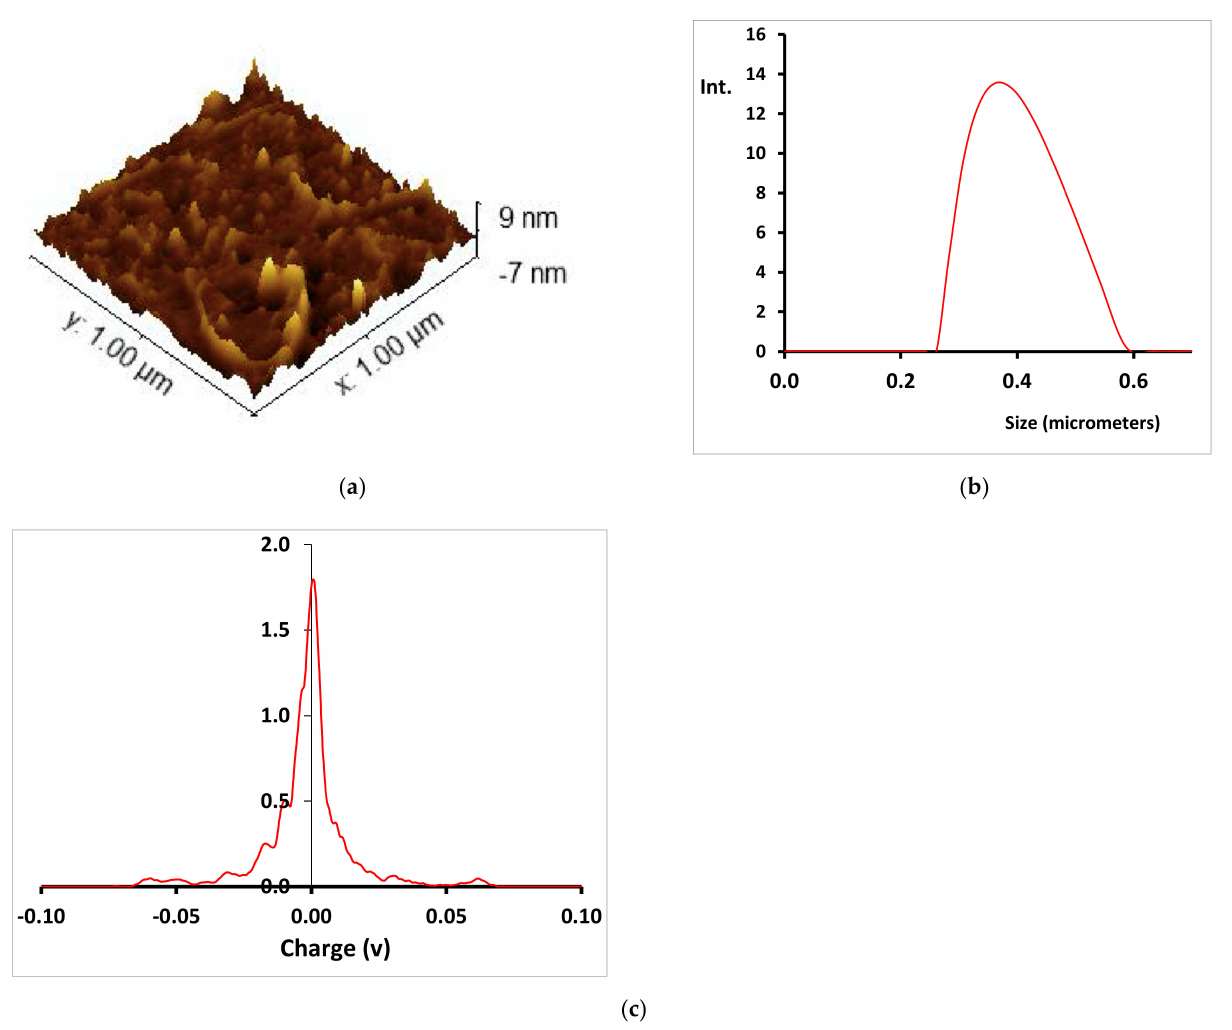
Figure 3. ( a ) AFM image, ( b ) DLS spectra and ( c ) Zeta potential of